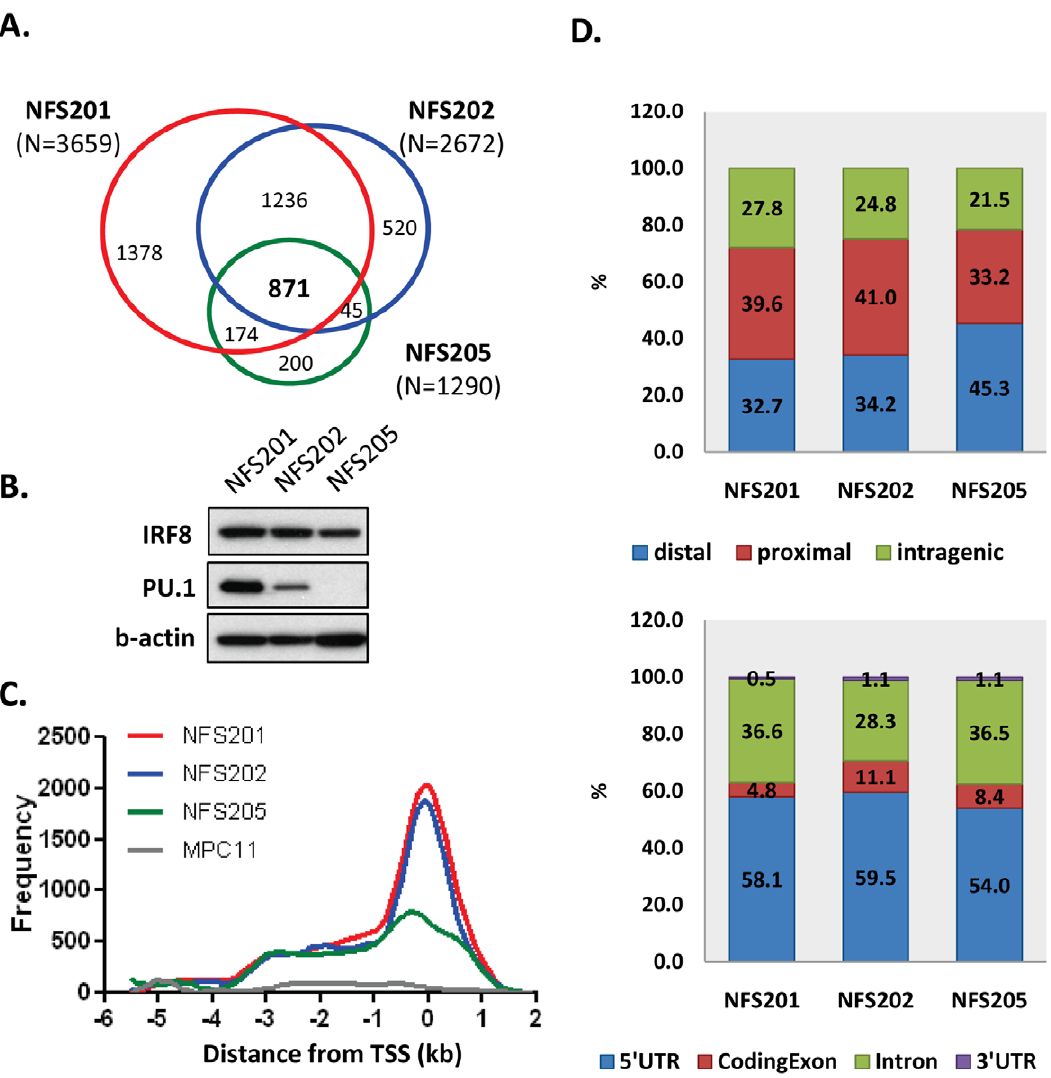
Figure 3. Identification of IRF8 and PU.1 targets in mouse cell lines of GC B cell origin. Labeled IRF8 ChIP samples and input samples were applied to Nimblegen MM8 385 k arrays and peak signals were identified by sliding window algorithm with threshold of FDR , 0.01. (A) A Venn diagram for IRF8 targets. Numbers in parentheses indicate the number of IRF8 targets identified in each line. Venn diagram shows the number of IRF8 targets that belong to each area. (B) Western blots for IRF8 and PU.1 in the three cell lines. (C) Distribution of IRF8 ChIP hits by chromosomal location relative to transcription start sites (TSS). (D) Distribution of IRF8 binding related to the annotated structure of associated genes (top). The frequencies of IRF8 hits in the sub-structure of intragenic locations